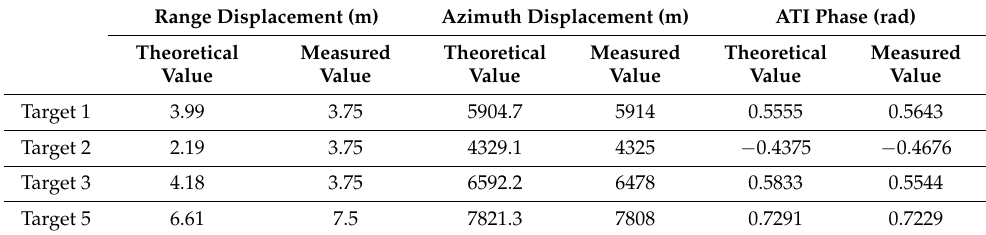
Table 3. Characteristic Measurement of Moving